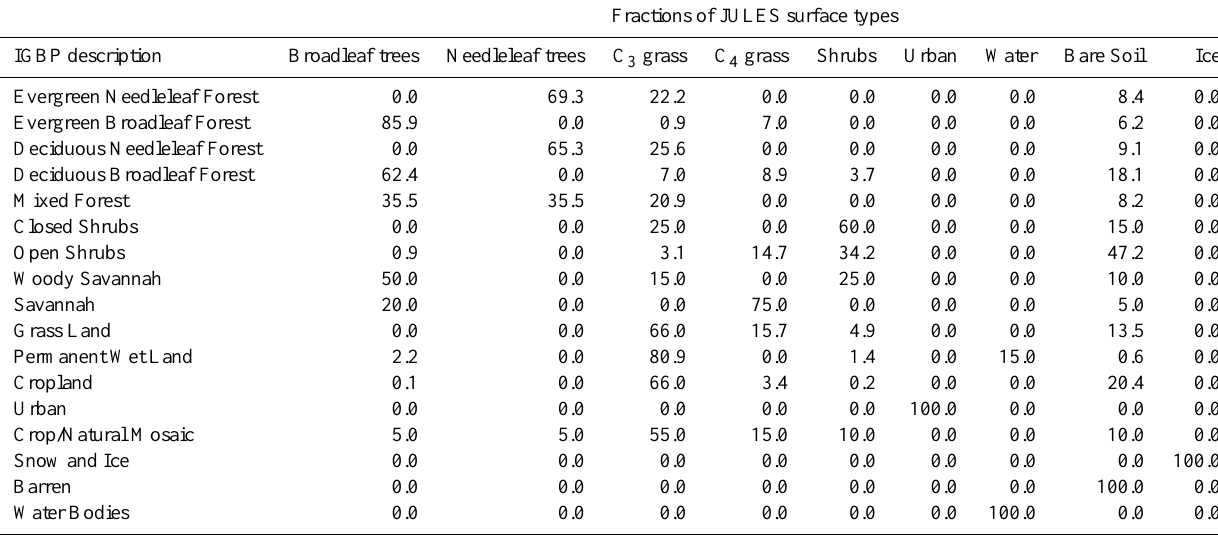
Table 2. Conversion of IGBP land cover classes into JULES fractions of surface types.